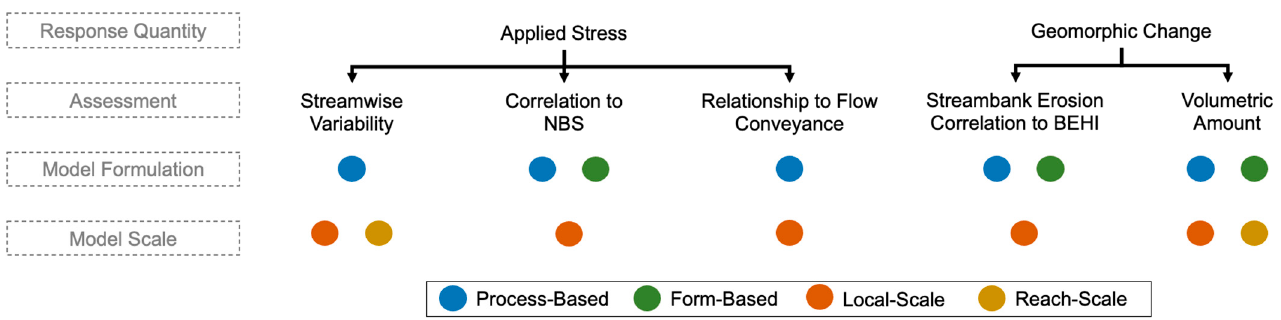
Figure 4. Model-to-model assessments conducted for quantifying the impact of model selection when predicting applied stresses and volumetric amounts of geomorphic change.